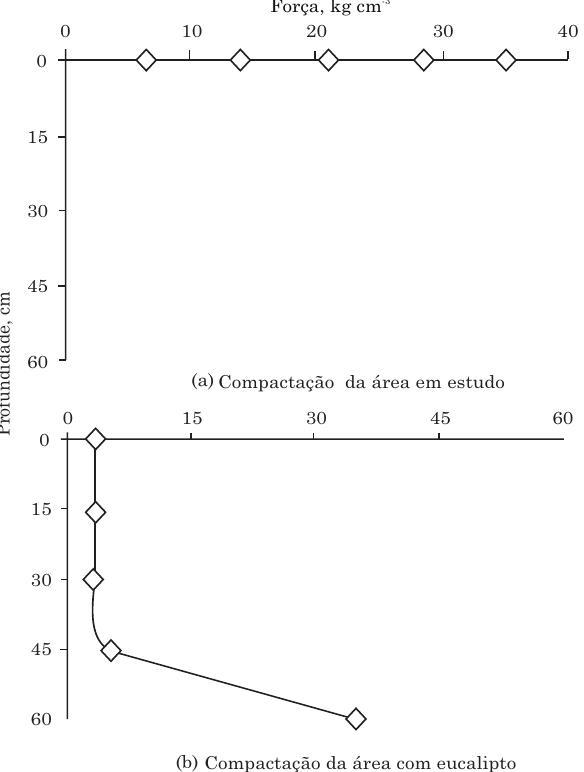
Figura 1. Profundidades alcançadas pelo penetrógrafo na área em estudo (a) e na área vizinha com plantio de eucalipto